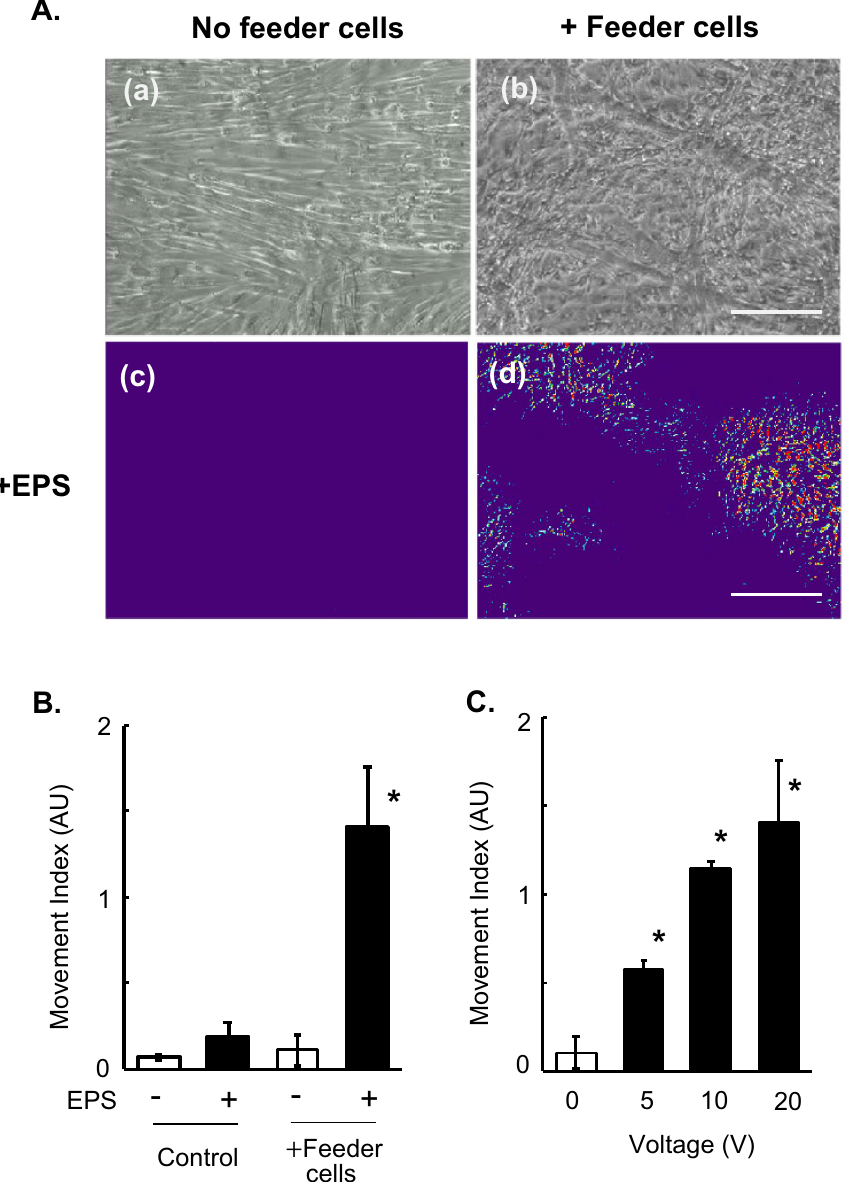
Figure 1. Contractile activity of human myotubes with or without mouse fibroblast feeders. After 7–8 days of differentiation, EPS (1 Hz frequency, 4-ms duration, 20 V/25 mm) was applied to differentiated human myotubes (derived from HSMM) cultured without ( panels a and c ) or with ( panels b and d ) feeder 3T3L1 fibroblasts for a total of 24 h (8 h × 3 times with 1 h interval between sessions). Images of myotubes were then taken during the last 15 min of the total EPS session (Supplementary Movies S1 and S2). ( A ) The pseudo- colored differential images ( panels c and d ), reflecting contractile area and ability, were produced as described in the “Methods” section. The bright-field images of the same area ( panels a and b ) are also presented. Scale bar = 250 μm. Three independent experiments were performed and representative images are presented. ( B ) The Movement Index was determined as described in the “Methods” section. *Significant effects compared to No-EPS ( n = 3, * p < 0.05). ( C ) The EPS intensity-dependent contractile activity of the feeder-supported in vitro exercise model was determined by the Movement Index at varying voltages (5, 10 and 20 V/25 mm) of EPS (1 Hz frequency, 4-ms duration). The statistical significance was determined by ANOVA with Tukey’s multiple comparison test. *Significant effects compared to No-EPS (0 V EPS) ( n = 3, * p <